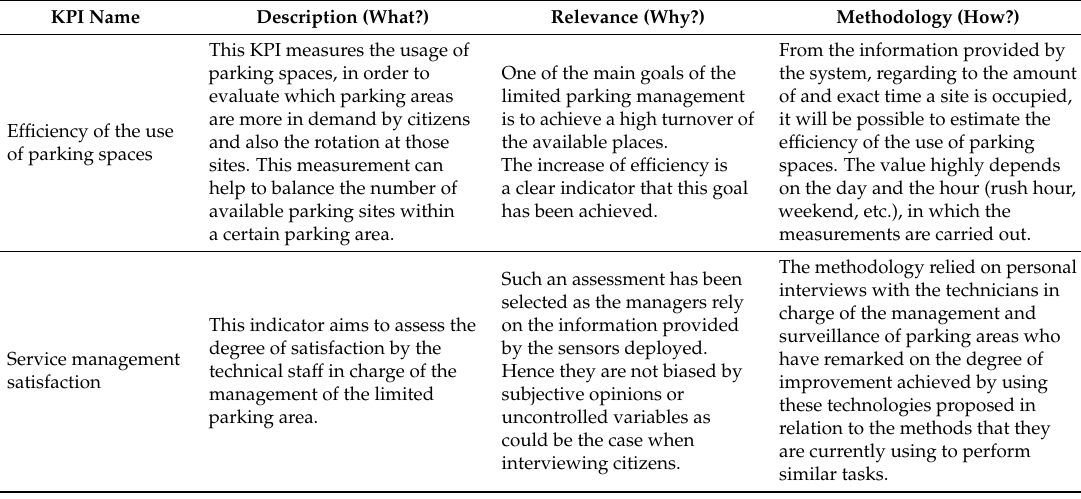
Table 1. Smart parking key performance indicators evaluated.